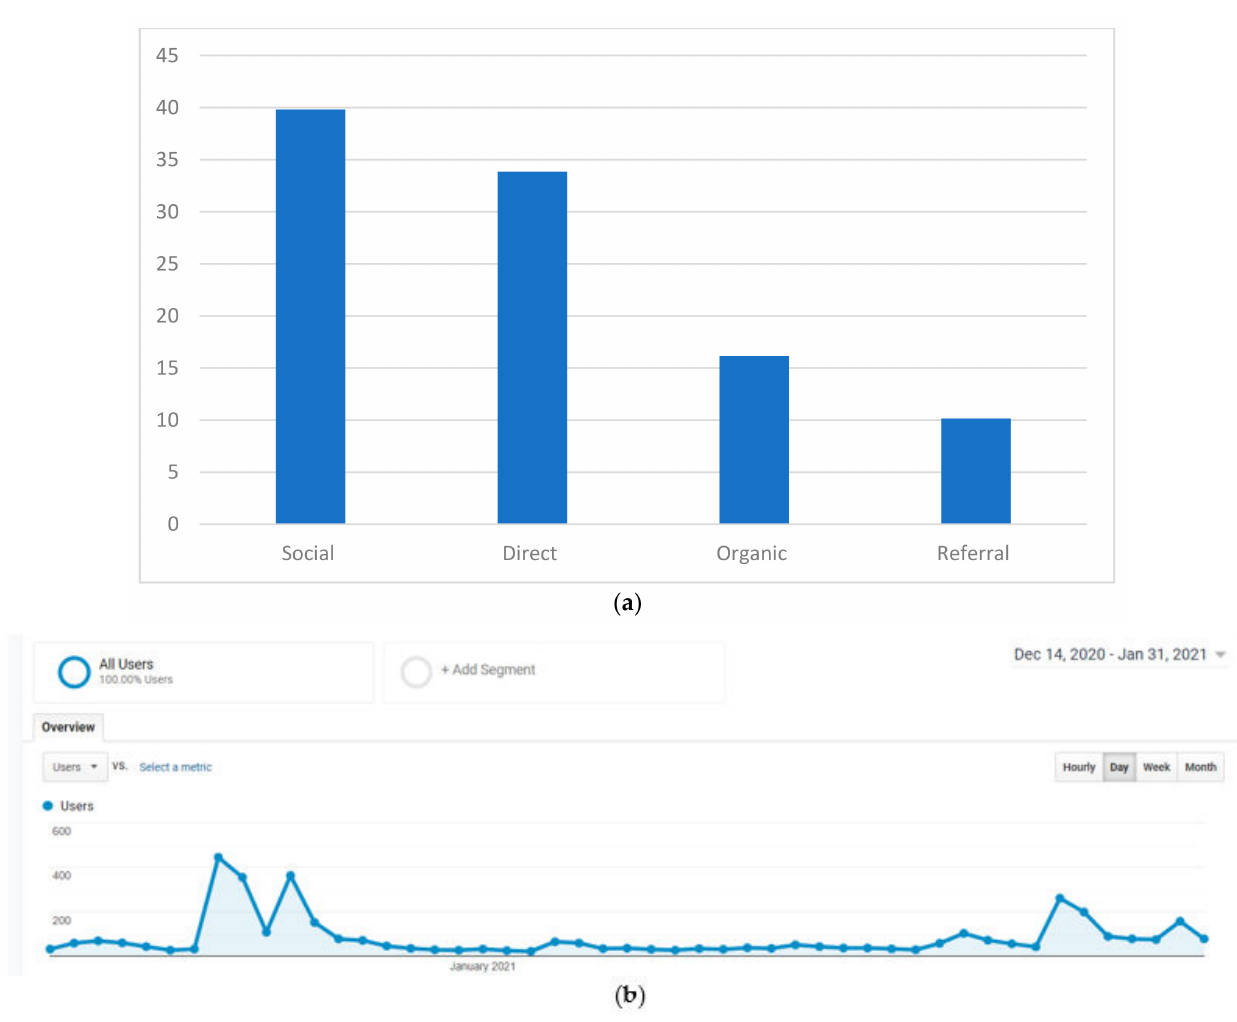
Figure 14. ( a ) User interactions (November 2020–February 2021). ( b ) Visitor numbers corresponding to launch of new